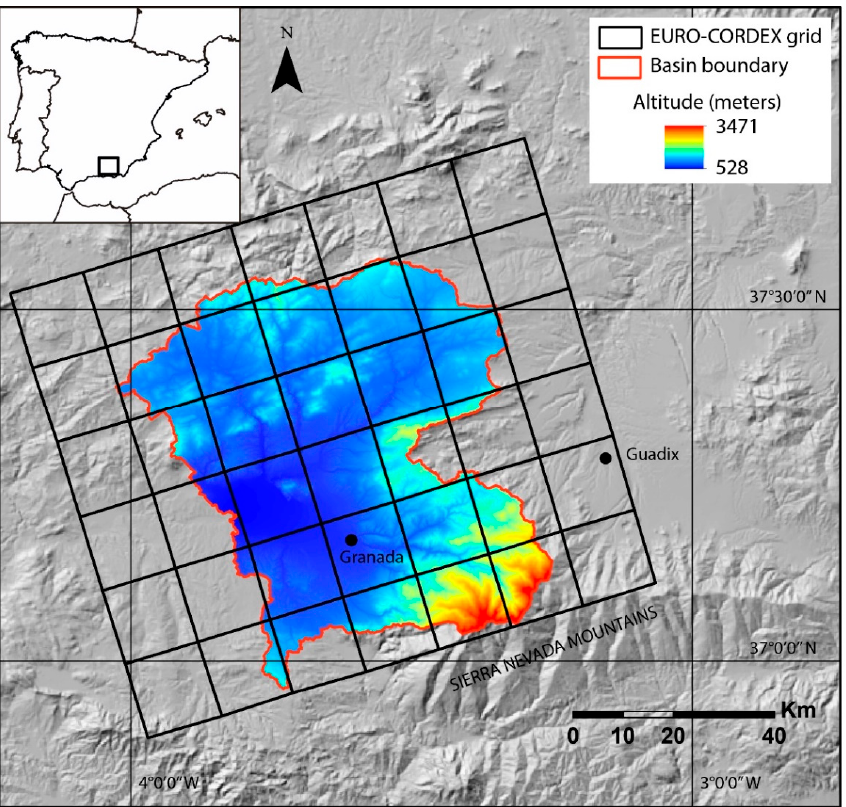
Figure 2. Location of the case study.